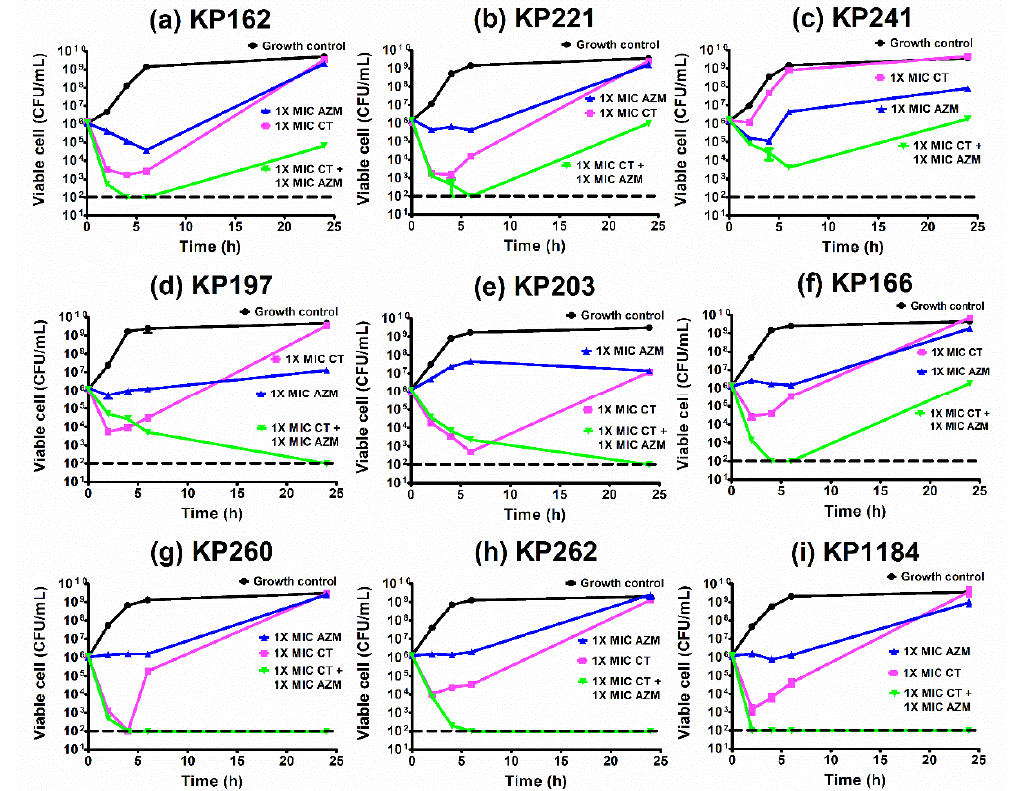
Figure 5. Time–kill curves of azithromycin and colistin combination against OXA-48-producing K. pneumoniae isolates. Synergism of azithromycin and colistin was confirmed by time–killing assays against KP162 ( a ), KP221 ( b ), KP241 ( c ), KP197 ( d ), KP203 ( e ), KP166 ( f ), KP260 ( g ), KP262 ( h ), and KP1184 ( i ). Mean of bacterial viable cells at each condition: growth control or without antibiotic (circles), colistin = 1 × MIC (squares), azithromycin = 1 × MIC (triangles), and colistin = 1 × MIC combination with azithromycin = 1 × MIC (upside down triangles) was plotted at 0, 2, 4, 6, and 24 h of incubation. All experiments were performed in triplicate and the detection limit of the viable cells was 102 CFU/mL (dashed lines). In combination, the synergism was observed in eight bla OXA-48 -carrying K. pneumoniae